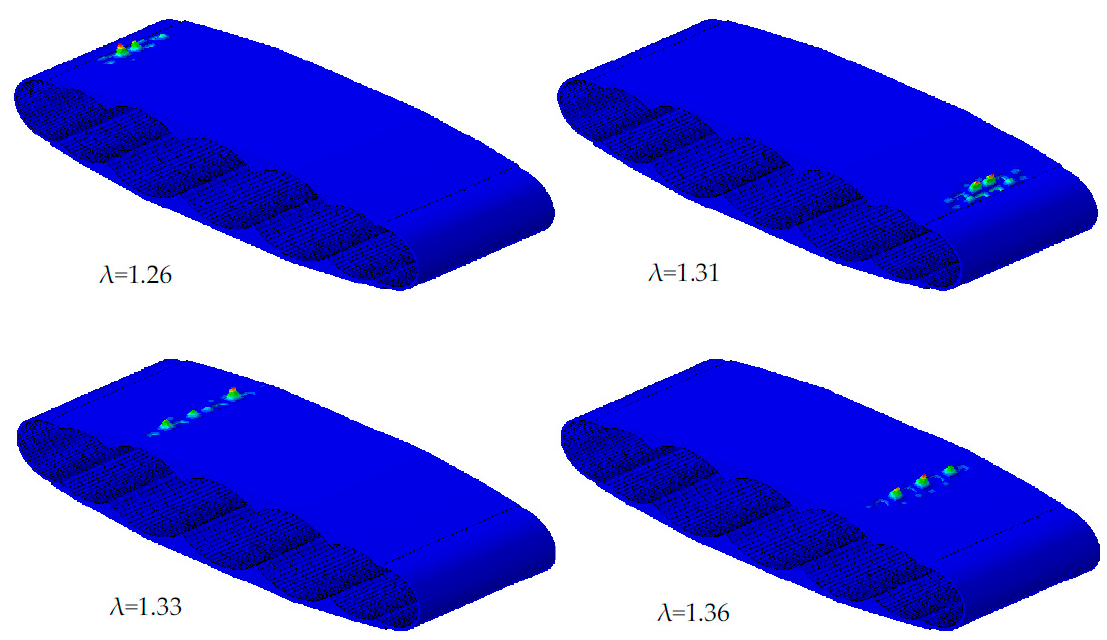
Figure 12. Four bucking modes of the linear buckling analysis for configuration 2 with 10 span-ribs, 10 frames.